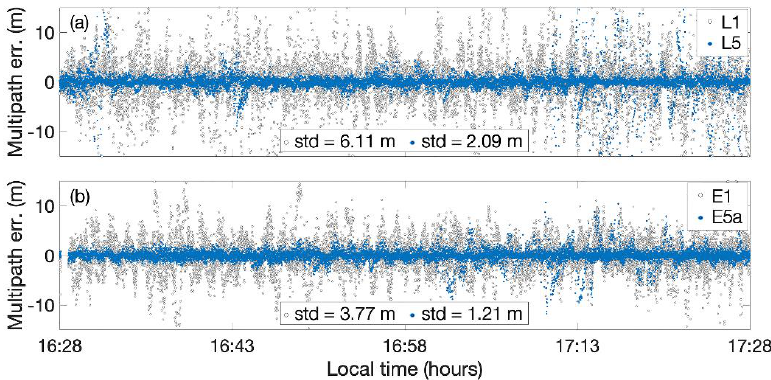
Figure 8. Code multipath comparison between L1/E1 (represented in grey) and L5/E5a (represented in blue) measurements from all the visible GPS ( upper ) and Galileo satellites ( lower ) collected by smartphone in the Portici site versus epoch.